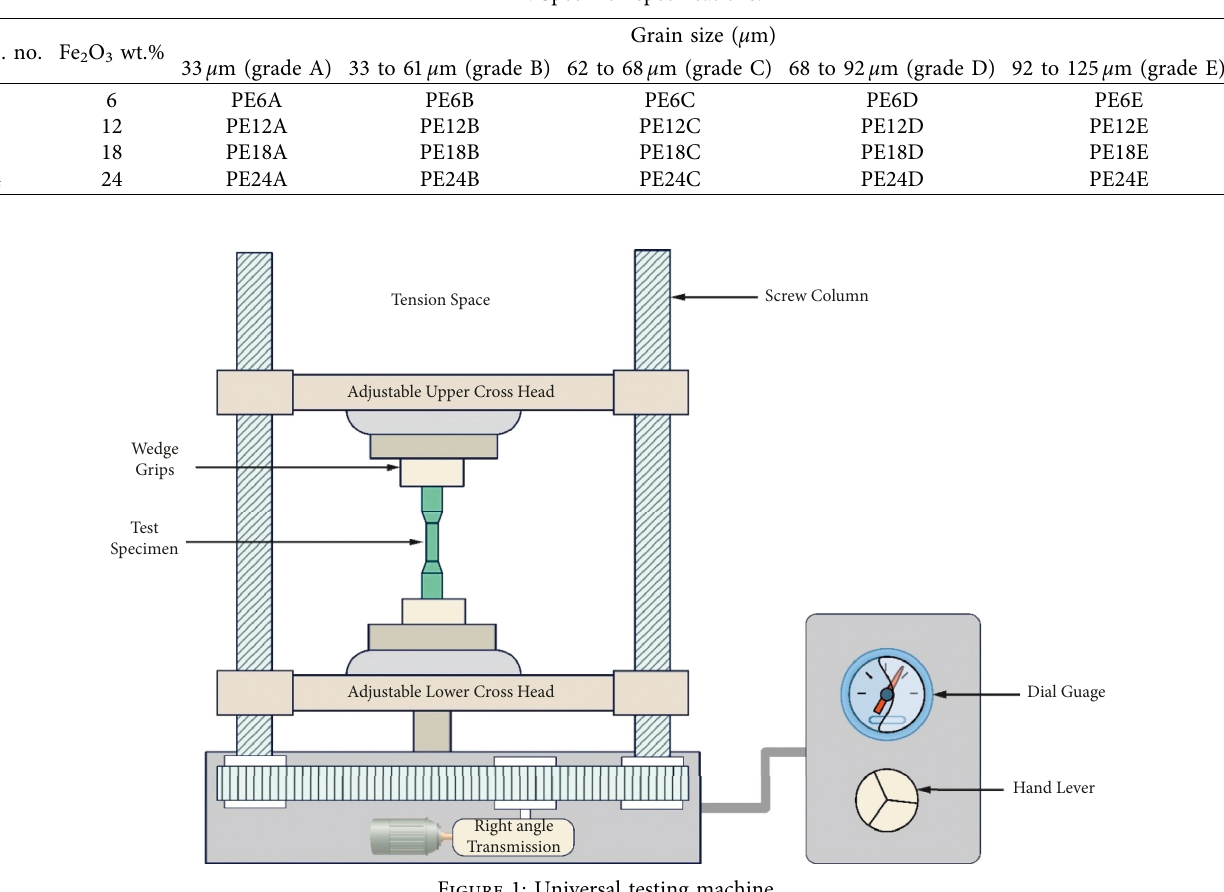
Table 1: Specimen specifications.